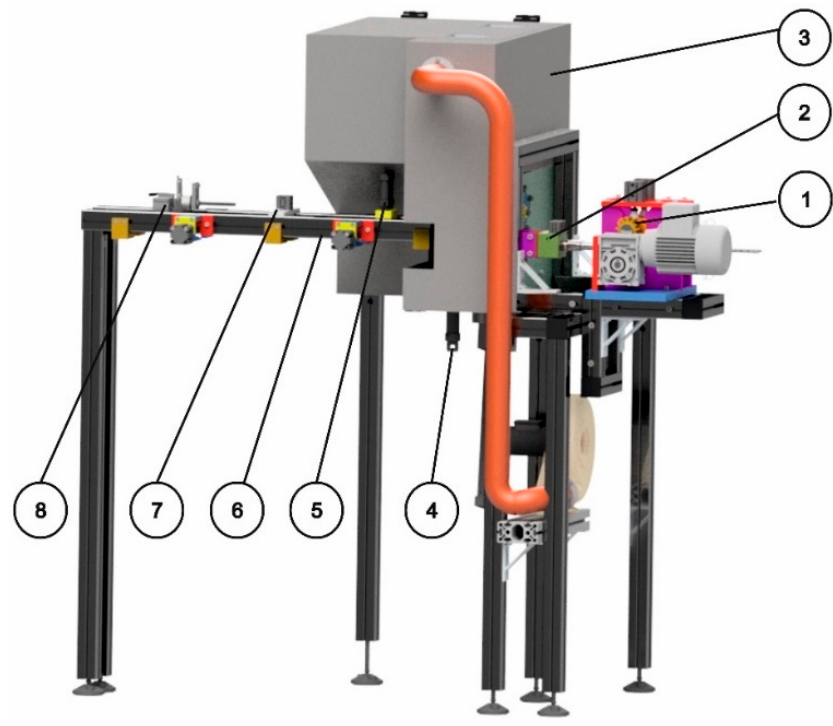
Figure 15. Layout of the cutting mechanism.